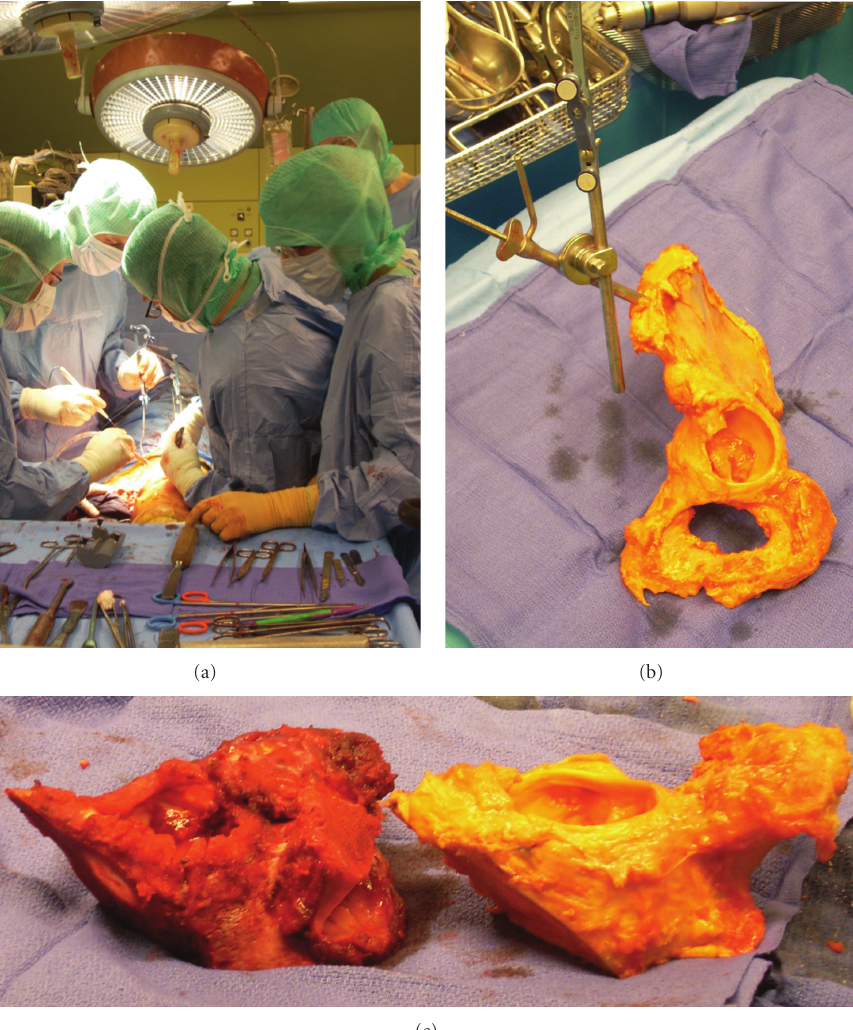
Figure 3: (a) Computer-assisted resection of the tumor. (b) Computer-assisted cutting of the allograft. (c) Tumor resected with safe margins (left) and allograft